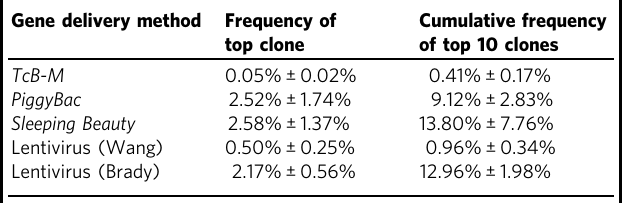
Summary table of the frequency of the top 10T cell clones and the respective percentages of those clones with the T cell population, following different gene delivery conditions. TcB transposon system was tested and compared with lentiviral transduction datasets 32,33 , as well as PiggyBac and Sleeping Beauty transposon systems 34 . Table displays mean±SD, biologically independent samples. n = 8 for TcB-M, n = 9 for SB, n = 9 for PiggyBac, n = 2 for LV (Wang), n = 4 for LV (Brady). Source data are provided as a Source Data fi le. Sequencing data used to